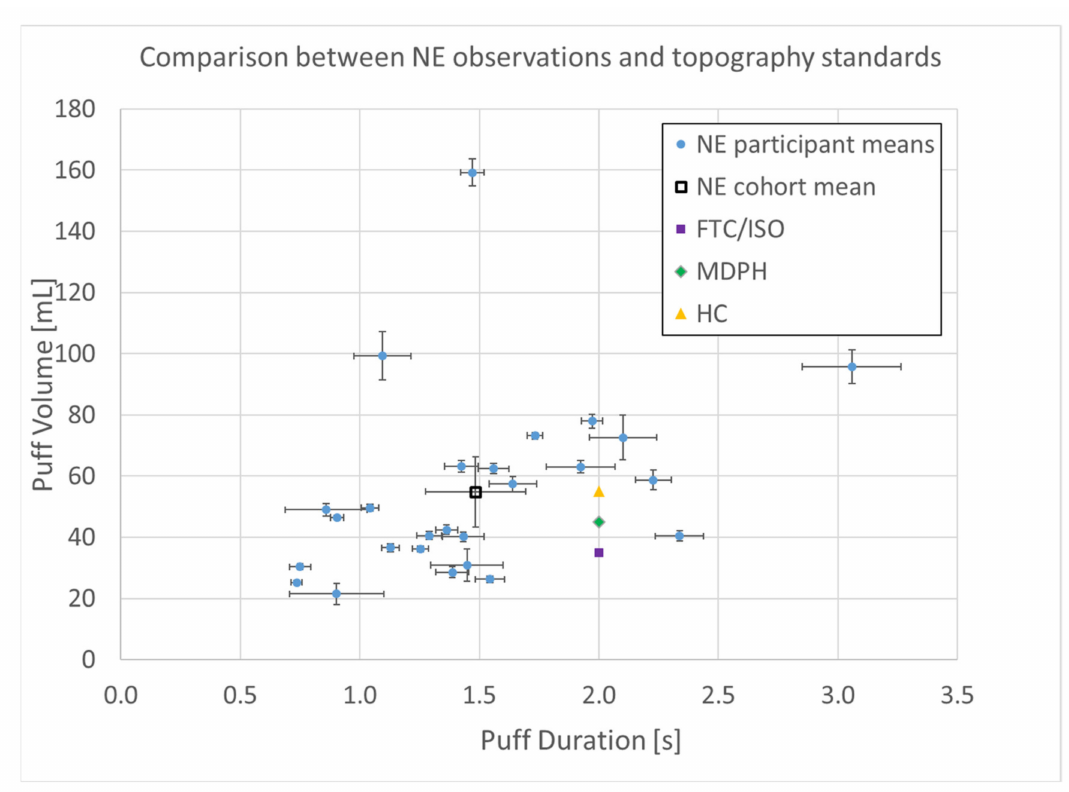
Figure 4. Pu ff topography distribution ( n = 8250 pu ff s) of ( n = 26 smokers) cigarette smokers in their natural environment (NE) during a week-long observation period. Shown are means with 95% confidence